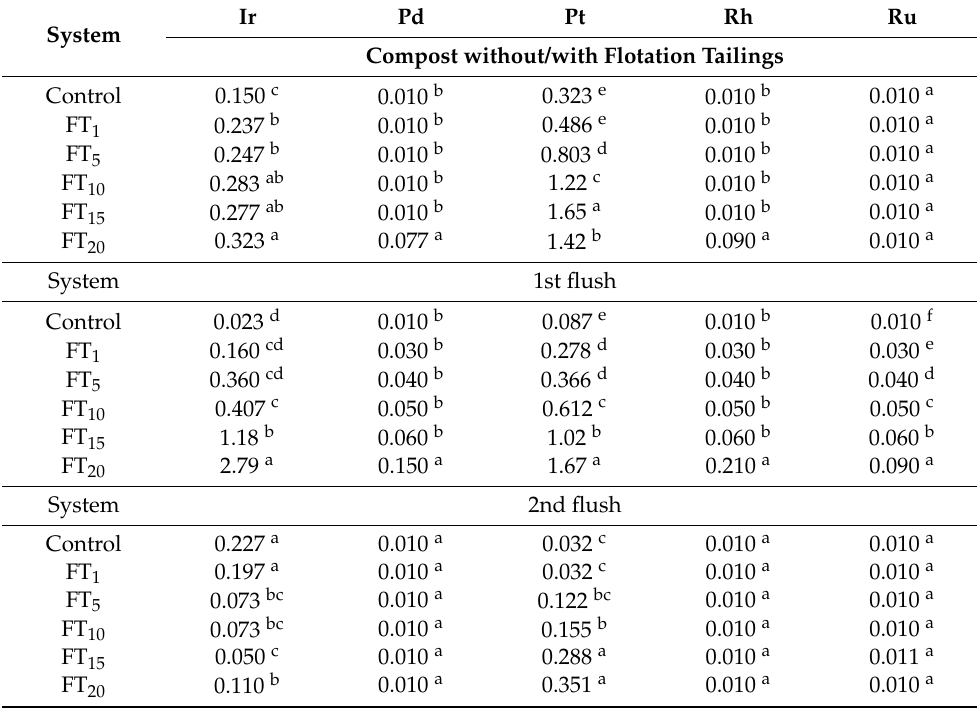
Table 6. Content of platinum group elements [mg kg − 1 dry weight] in compost with flotation tailings before the experiment and fruit bodies from particular